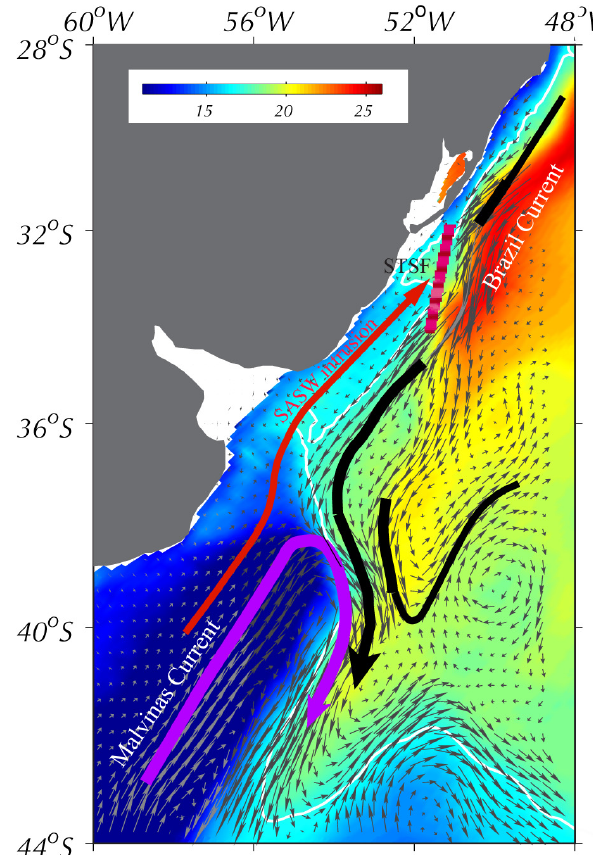
Fig. 13. Snapshot of SST and velocitities in EXP1. This figure shows a classic configuration of the circulation in this region, which is characterized by the detrainment of shelf waters onto the deep